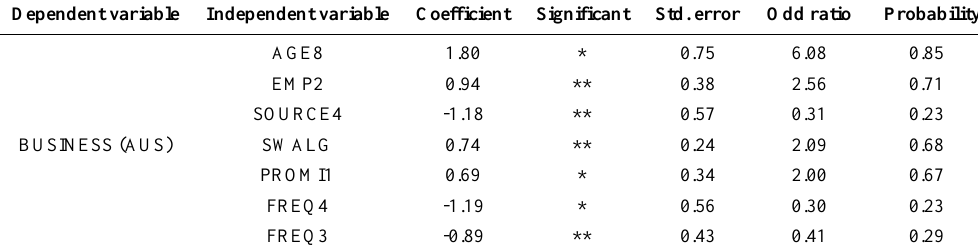
Table A-3. Business support and